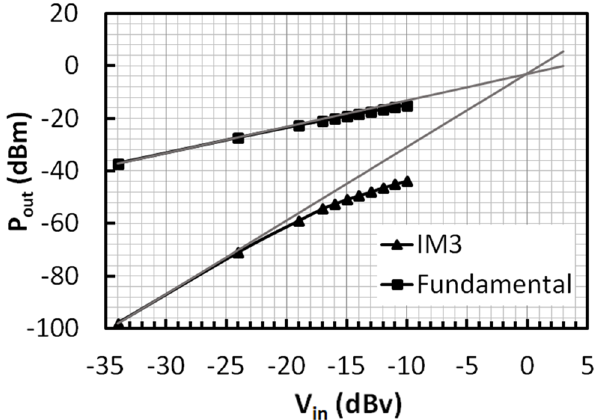
Figure 15. Measured IIP3 of the LPF (for the two-tone signals at 100 and 110 MHz).